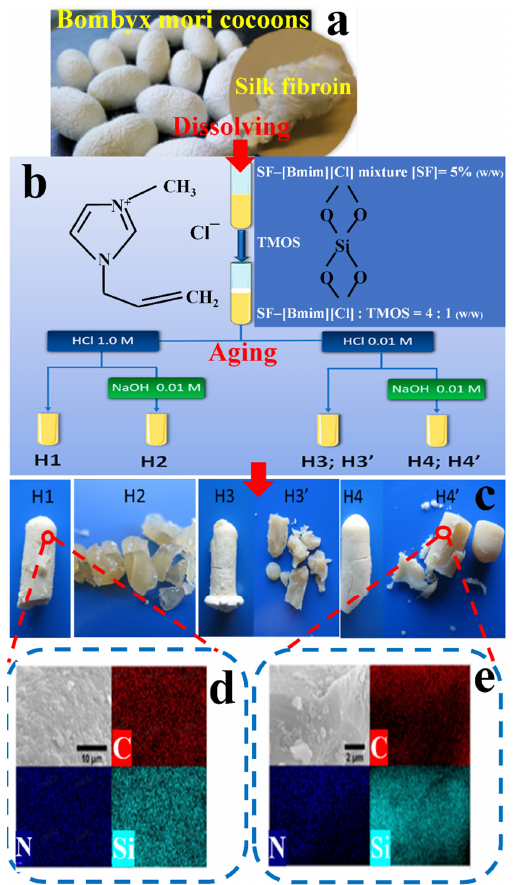
Figure 8. The scheme of preparation process of ( a ) SF ( b ) dissolved in [BMIM]Cl, blended with tetramethoxysilane (TMOS), and aged under different acidbase ratios. ( c ) Their appearance photos and ( d , e ) SEM images of H1 (10 μ m) and H4’ (2 μ m) at different scales, as well as corre- sponding EDX maps (red, navy blue and light blue in EDX map correspond to C, N and Si atoms respectively) (reproduced with permission from [115], https://pubs.acs.org/doi/10.1021/acsomega.8b02051, 7 September 2018, open access copyright (2018) American Chemical Society).